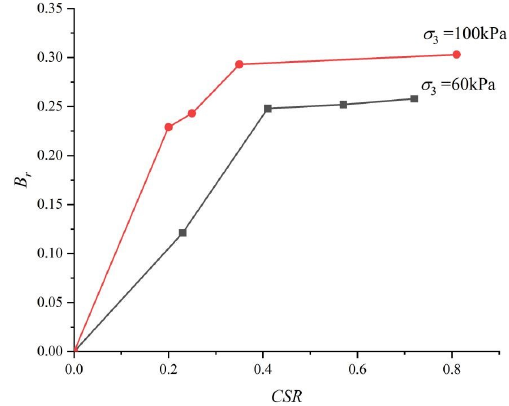
Figure 19. Relative breakage rate Br after cyclic loading.